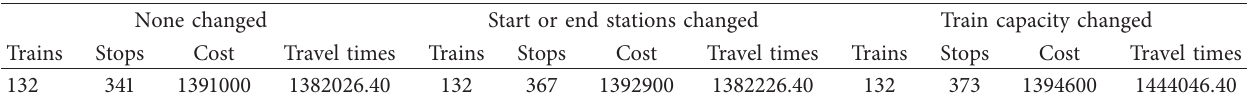
Table 6: Comparison for sensitivity